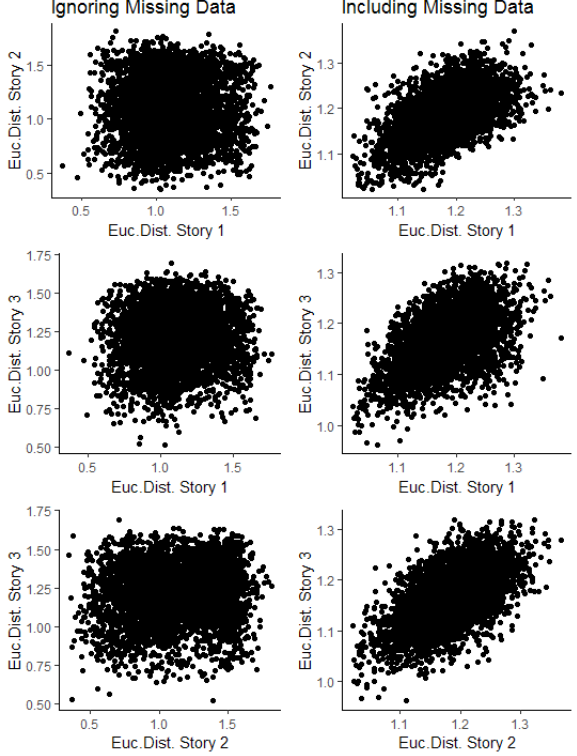
Figure 2. Scatterplots of Euclidean distances between reading be- haviors across stories. The figures illustrate how similar each pair of subjects’ gaze durations were in one story, versus how similar they were when reading the other story. Left panels represent data where missing data points were ignored. It is clear that no strong relationship between the reading pattern differences exist. Right panels represent data where missing data points were treated as 0-durations. In this analysis, it becomes clear that subject pairs do show similar reading patterns across